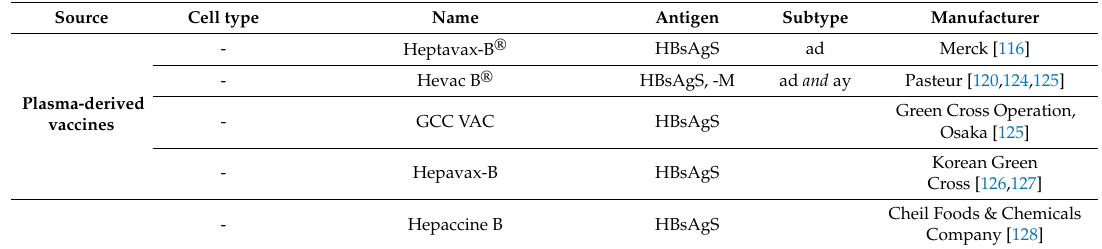
Table 1. Key vaccines against HBV utilizing hepatitis B surface